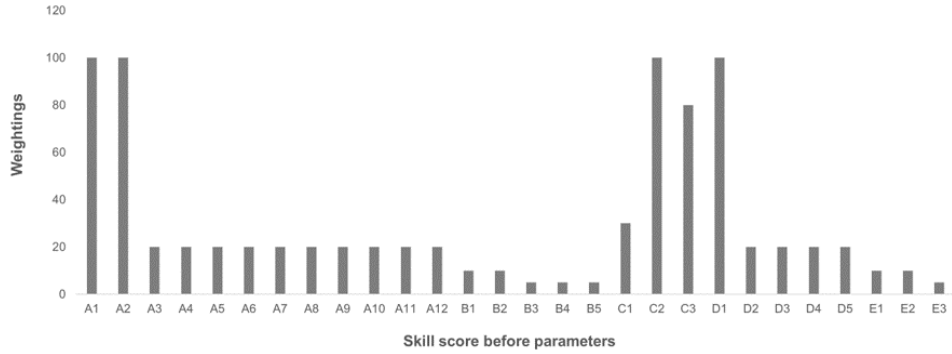
Figure 4. Overview of the final weightings of the cost score